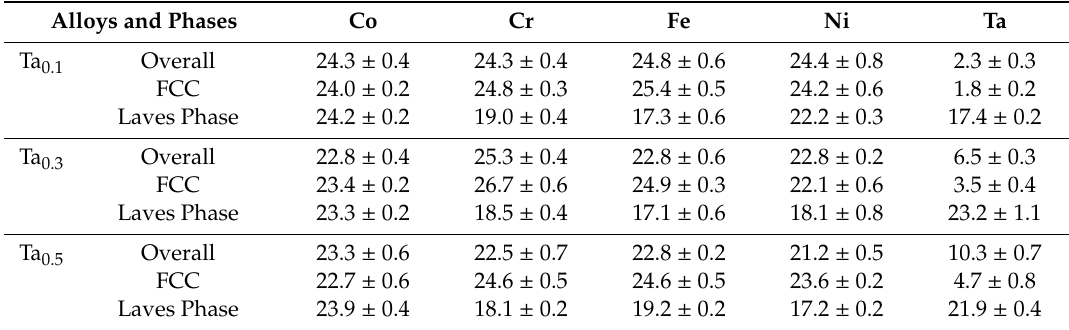
Table 3. Overall chemical compositions and phase compositions (wt.%) of as-cast CoCrFeNiTa x alloys analyzed by SEM / EDS.